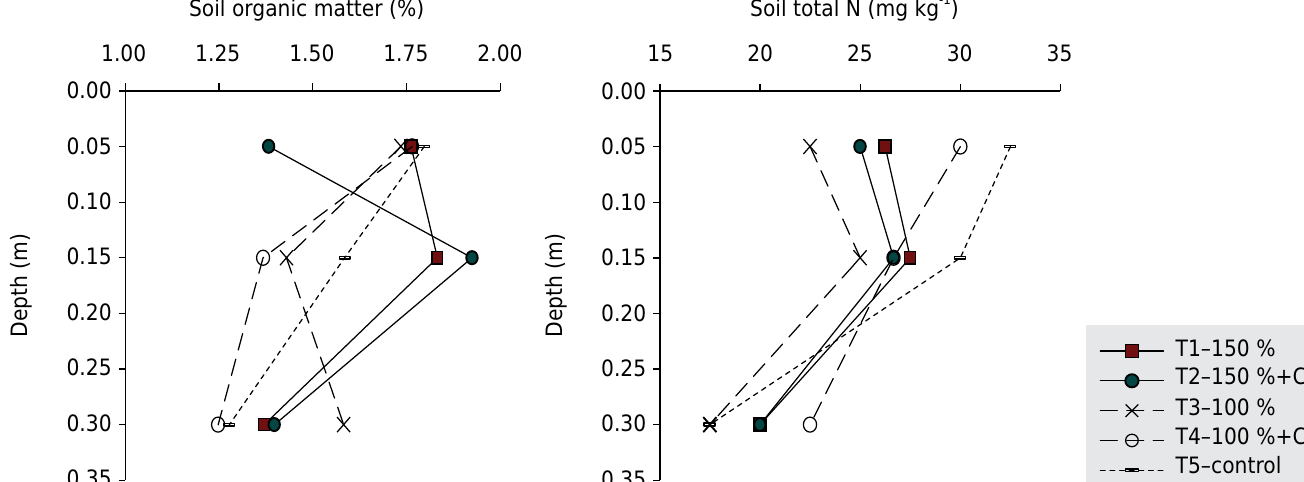
Figure 2. Average values of soil organic matter and soil total nitrogen in the 0.00-0.10, 0.10-0.20, and 0.20-0.40 m layers after the